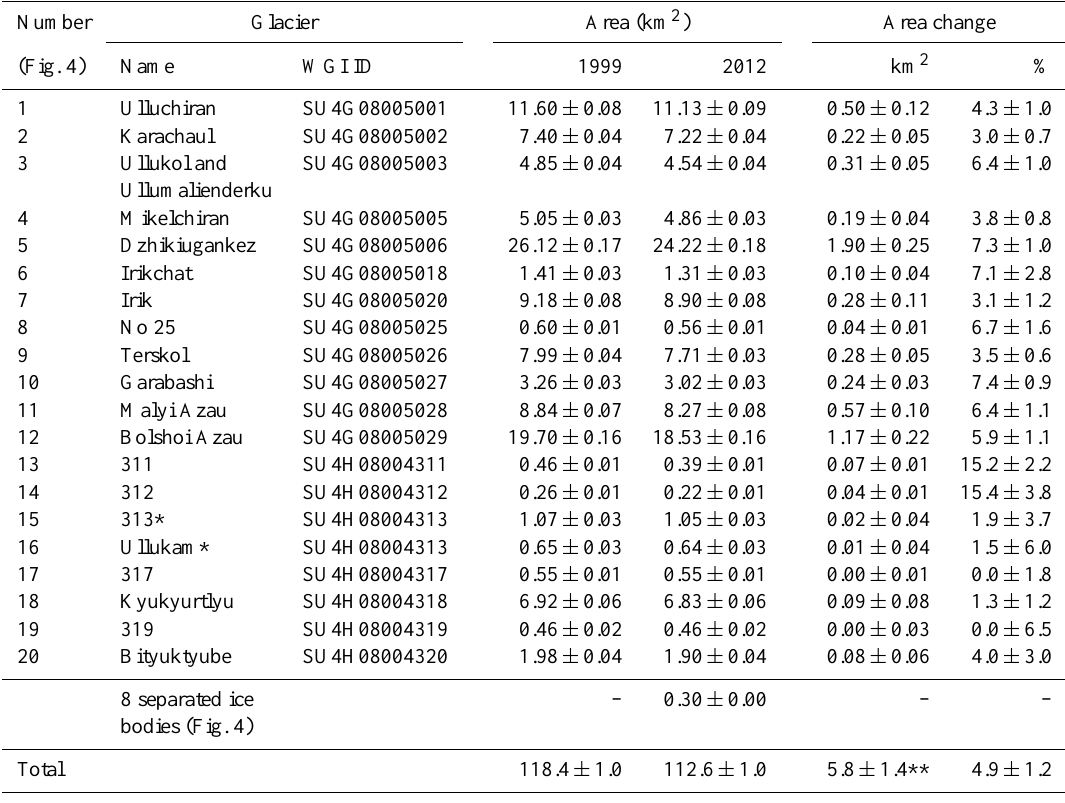
Table 4. Changes in map areas of glaciers located on Mt. Elbrus between 1999 and 2012. All glaciers are shown in Fig. 4.